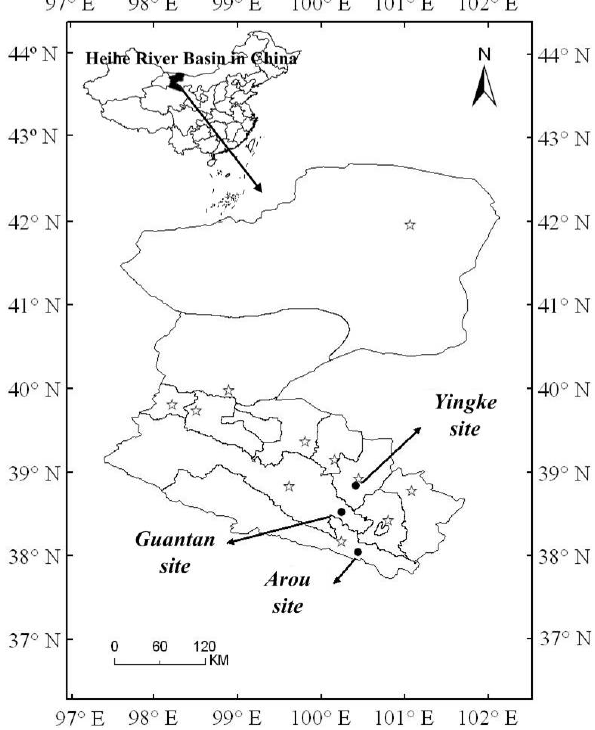
Fig.1. Locations of observation sites (the star symbol represents the city in the Heihe River Basin).